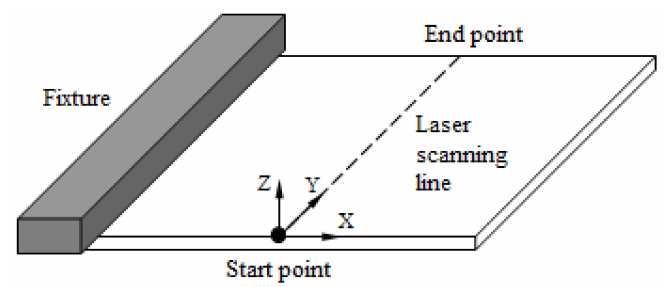
Figure 1. Schematic view of the laser-forming experiment